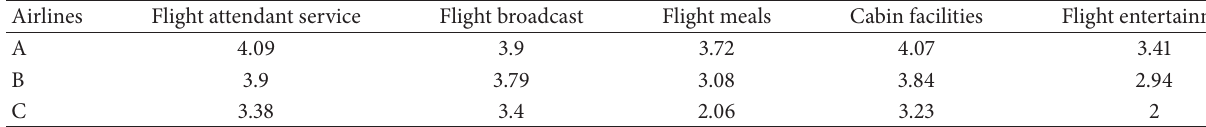
Table 2: Evaluation values of airline service.